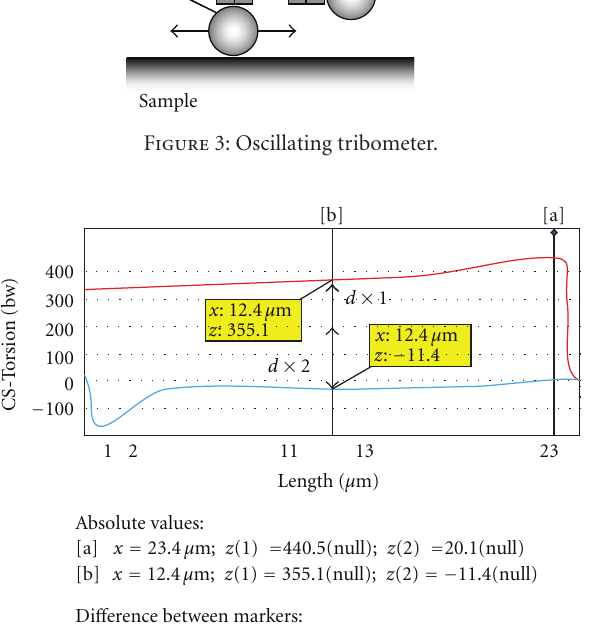
Figure 4: Typical mode for the lateral friction force determination results.